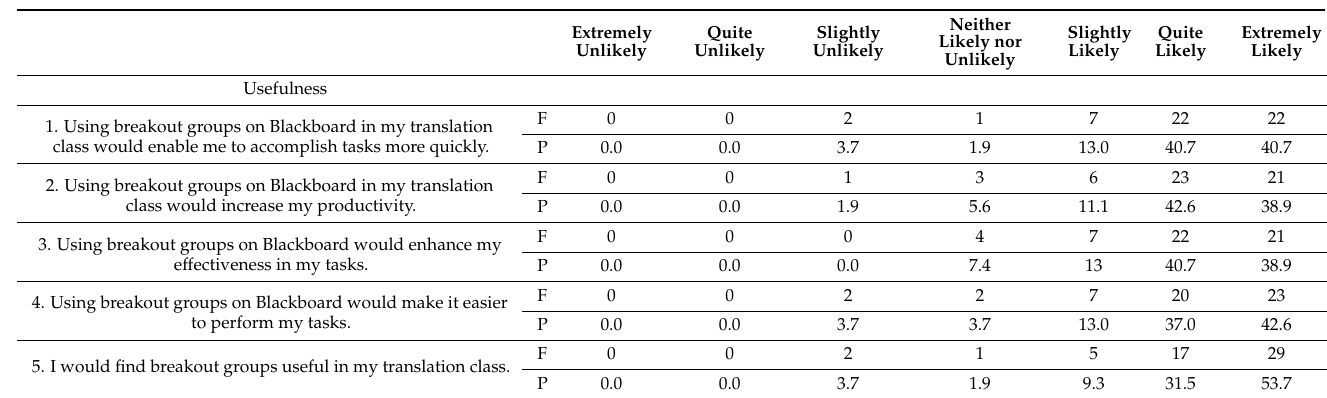
Table 8. Frequency table for perceived usefulness.